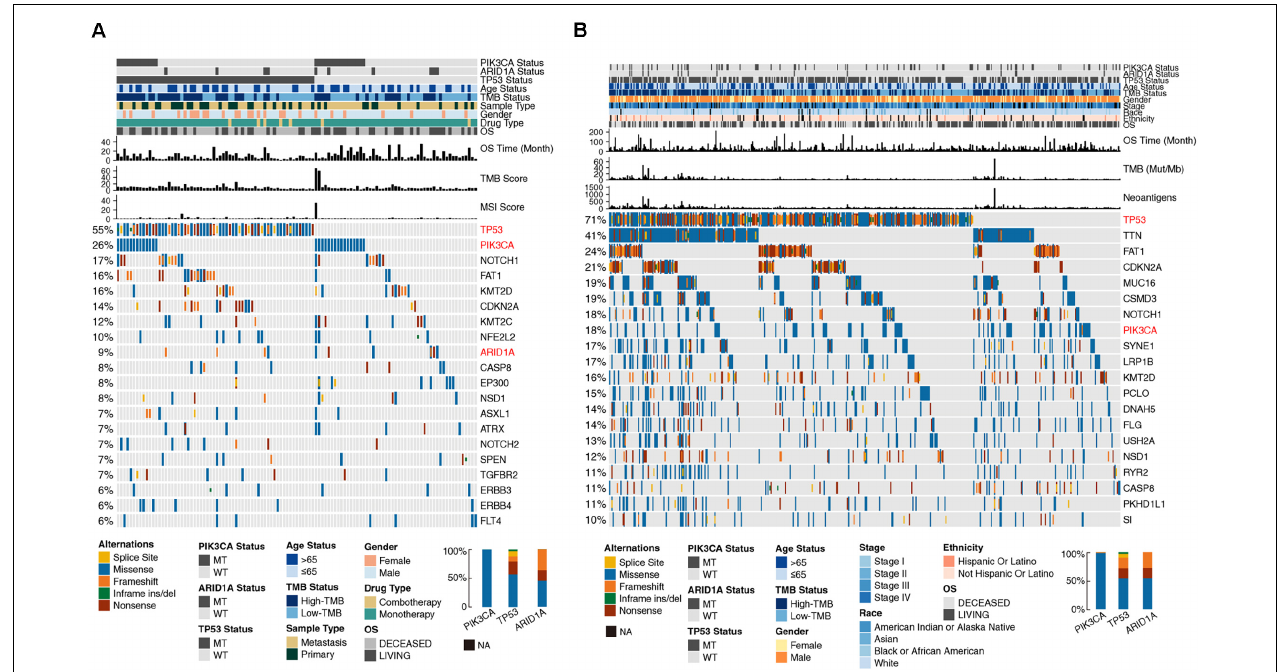
FIGURE 2 | Genomic profiles of HNSC patients in the MSKCC (A) and TCGA (B) cohorts. The top 20 genes with the highest mutation frequencies and the corresponding clinical information are shown in the figure. The top five genes with the highest mutation frequencies in the MSKCC cohort were TP53 (55%), PIK3CA (26%), NOTCH1 (17%), FAT1 (16%), and KMT2D (16%). The top six genes with the highest mutation frequencies in the TCGA cohort were TP53 (71%), TTN (41%), FAT1 (24%), CDKN2A (21%), MUC16 (19%), and CSMD3 (19%). Among the three genes selected from the multivariate Cox regression analysis, TP53 had the highest mutation rate in both clinical cohorts (55 and 71%, respectively), followed by PIK3CA (26 and 18%, respectively), and ARID1A (9 and 4%, respectively). The alteration types of TP53 were dominated by missense, nonsense and frameshift mutations. Missense mutations were the main mutation type of PIK3CA, and nonsense and frameshift mutations were the main mutation types of ARID1A. The mutation types are indicated as follows: yellow indicates splice sites, blue indicates missense mutations, orange indicates frameshift mutations, green indicates inframe insertion/deletion, and brown indicates nonsense mutations. The mutation status of ARID1A, PIK3CA, and TP53, TMB status, MSI score, neoantigen status, OS, and other clinical characteristics are shown as patient annotations (upper barplot). The left barplot marks the mutation rate of each gene. Genes marked in red represent the three genes screened from the multivariate Cox regression analysis. In the figure legends, “MT” represents patients with a certain gene mutation, and “WT” represents patients without certain gene